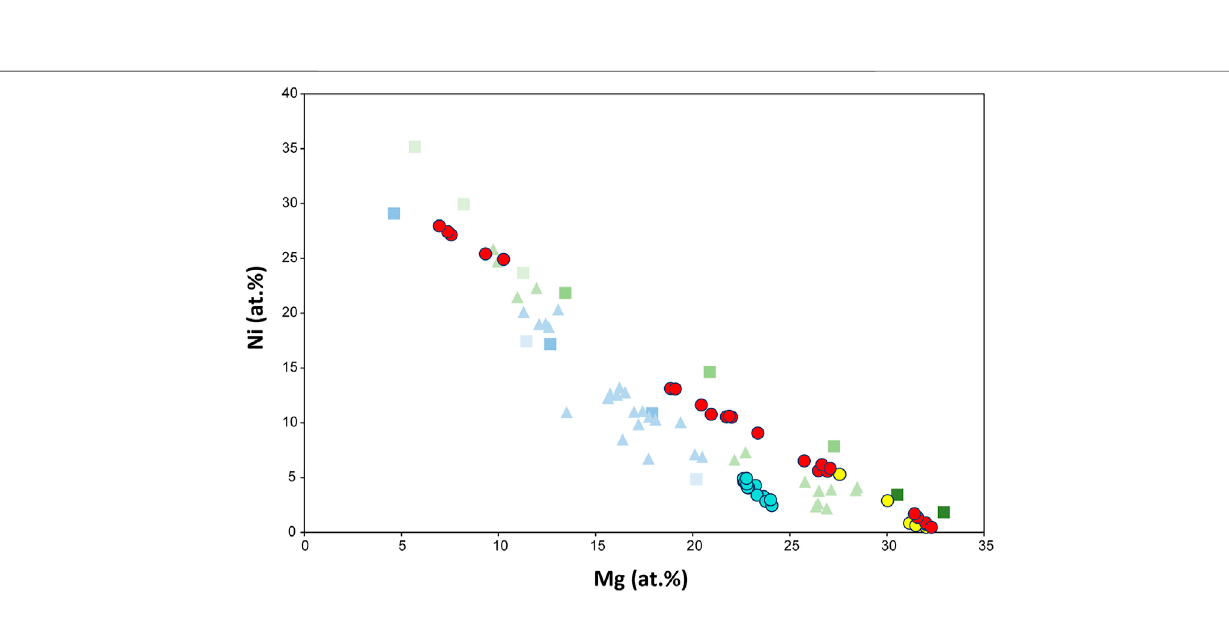
Frontiers in Earth Science |